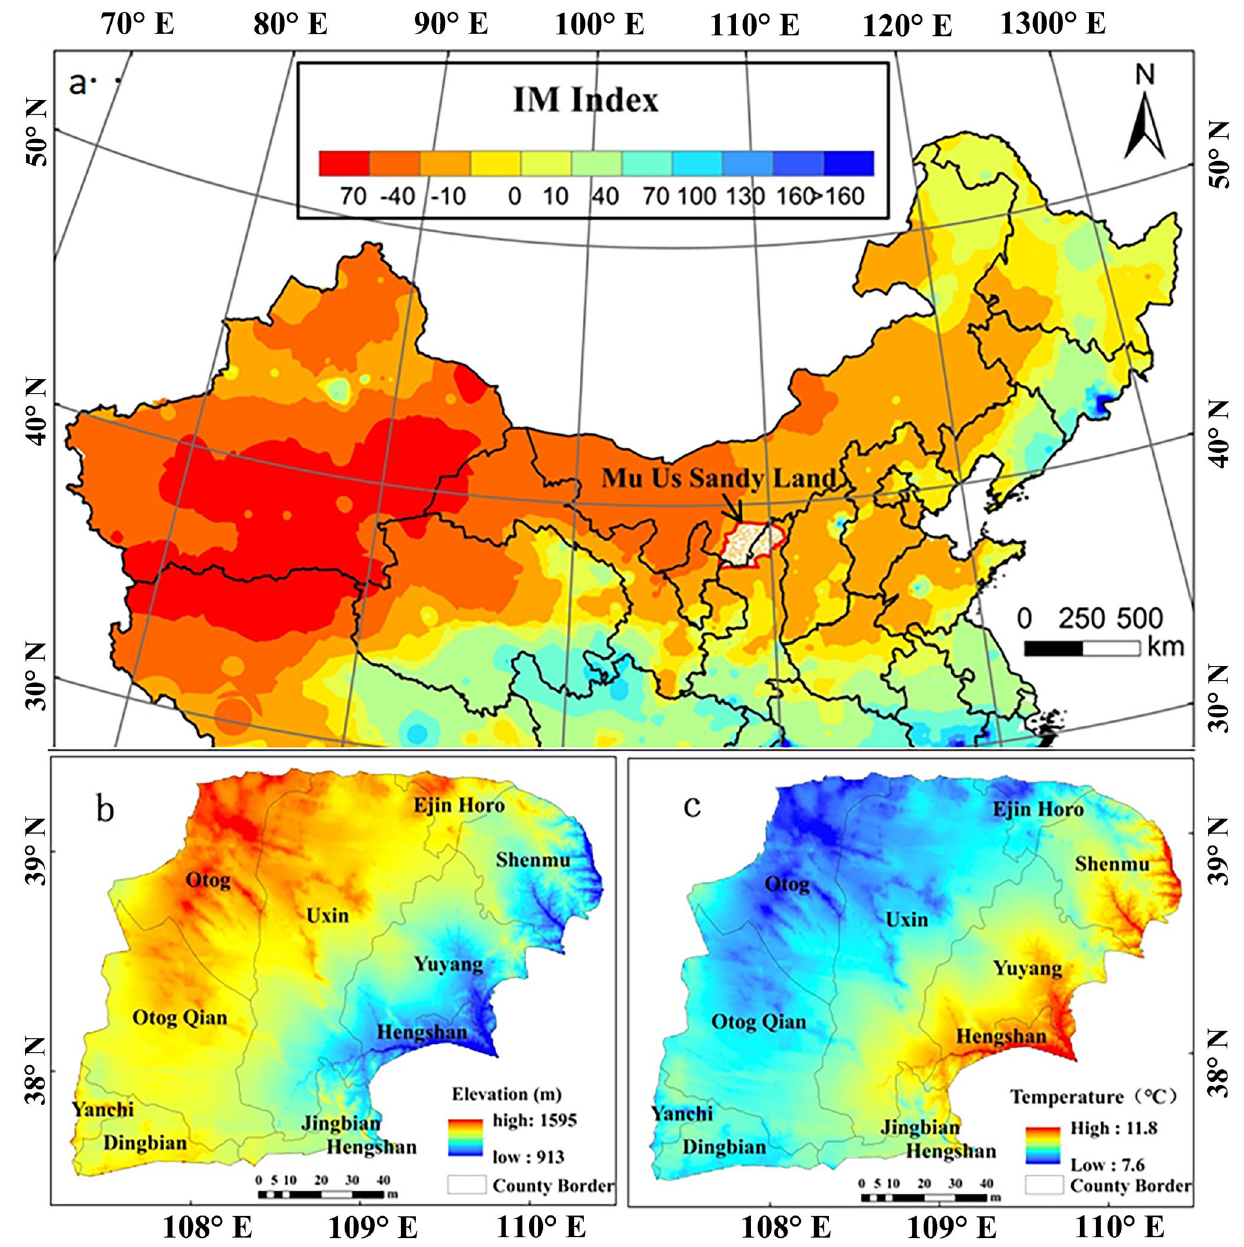
Figure 1. Geographic location map of the Mu Us Sandy Land. ( a ) Wetness index map of Northern China and the Mu Us Sandy Land was based on Xu’s Chinese meteorological background data set 42 . ( a ) Location, ( b ) elevation map was extracted from the elevation of China (http://www.resdc .cn/data.aspx?DATAI D=123), and ( c ) distribution of mean annual temperature was derived from the spatial difference data set of China’s average temperature in 2015 42 (http://www.resdc .cn/data.aspx?DATAI